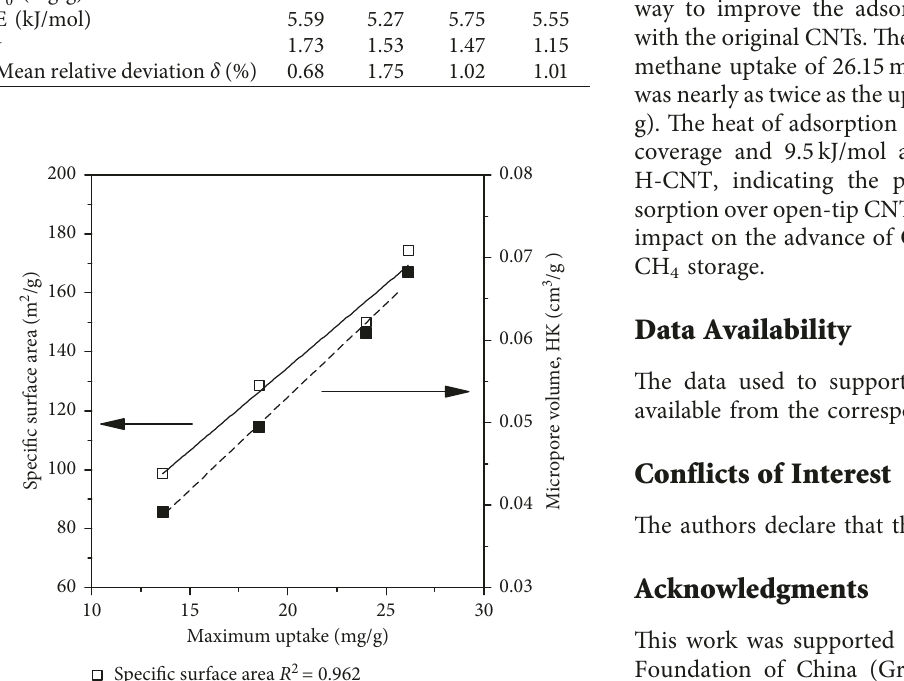
ads ) against different surface